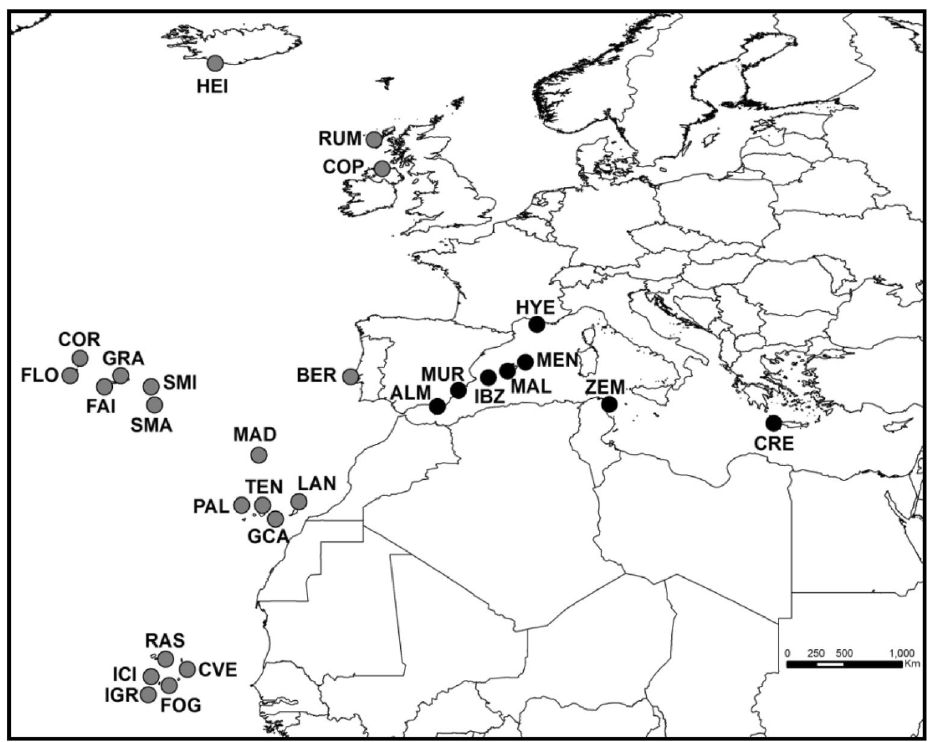
Figure 1. Map of the study area showing location of the 28 sample sites for feather mites on procellariiform seabird species across the north-east Atlantic Ocean (grey circles) and Mediterranean Sea (black circles). Abbreviations of the sample sites are shown in Supplementary Table